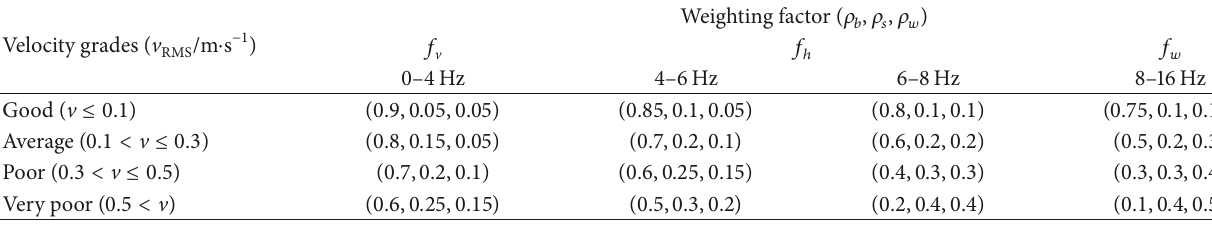
Table 3: Weighting factors for different disturbances.